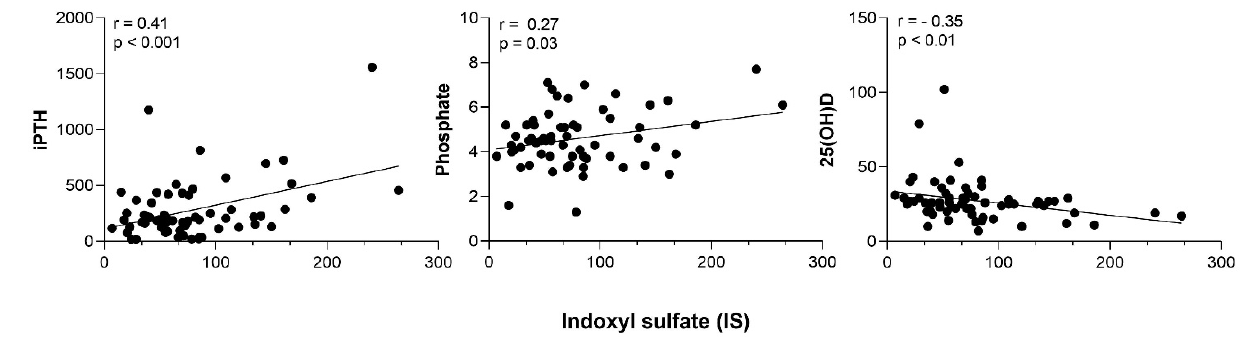
Figure 1. Percentual change in serum concentration of uremic toxins after 6 months of online he- modiafiltration (OL-HDF).